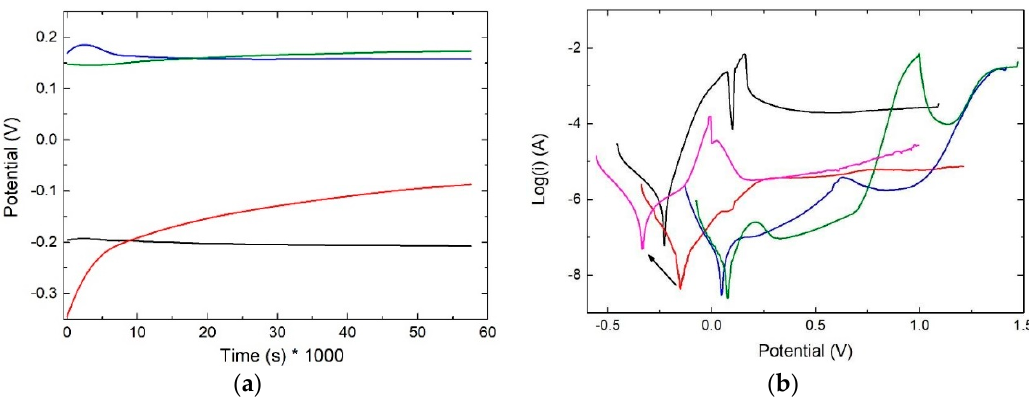
Figure 2. ( a ) Open circuit potential (OCP) measurement over 16 h of copper (black), bronze (red), palladium (blue) and gold (green). ( b ) Polarization curves recorded between − 0.25 and +1.3 V respect to the OCP after 16 h copper (black), bronze (red), palladium (blue) and gold (green). The measurement was performed also after the measurement of the OCP for 1 h in the case of bronze (pink).